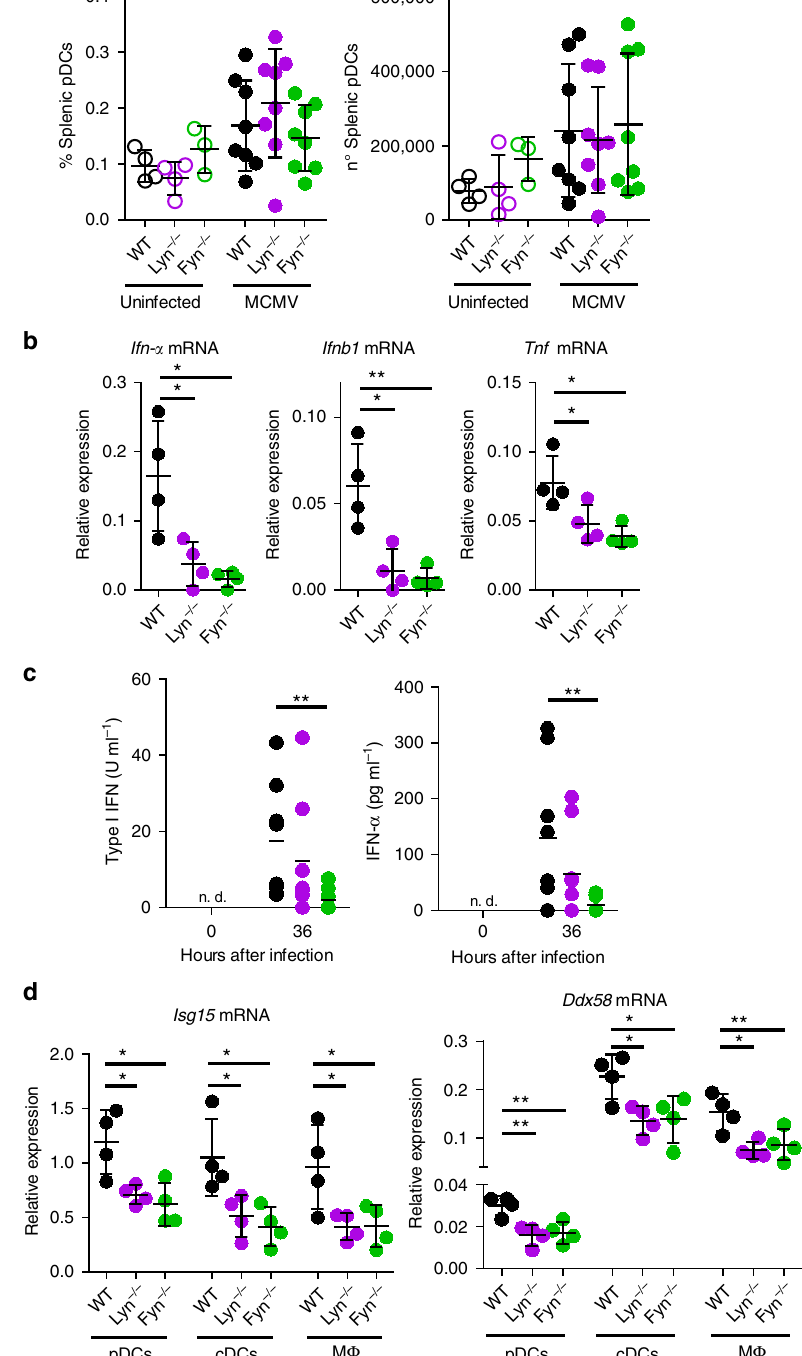
Figure 3 | Fyn and Lyn promote pDC responses after in vivo viral infection. WT (black), Lyn (cid:2) / (cid:2) (violet) or Fyn (cid:2) / (cid:2) (green) mice were infected with MCMV for 36h or left uninfected. ( a ) The proportion and number of pDCs were determined by FACS in spleen mononuclear cells. ( b ) The levels of Tnf , Ifna and Ifnb1 were determined by q-PCR in FACS-purified splenic pDCs. ( c ) Serum IFN- a and type I IFNs were determined by ELISA and bioassay, respectively. ( d ) The levels of interferon-stimulated genes Isg15 and Ddx58 were determined by q-PCR in FACS-purified splenic pDCs, CD11b þ cDCs and macrophages. ( a – d ) Data were obtained in two independent experiments with four mice per group each. Mean value alone or mean value ± s.d. are shown. Each symbol represents an individual mouse ( a , c ) or two pooled mice ( b , d ). Kruskal–Wallis test ( a , c ) and Dunnett’s multiple comparisons test ( b , d ) were used